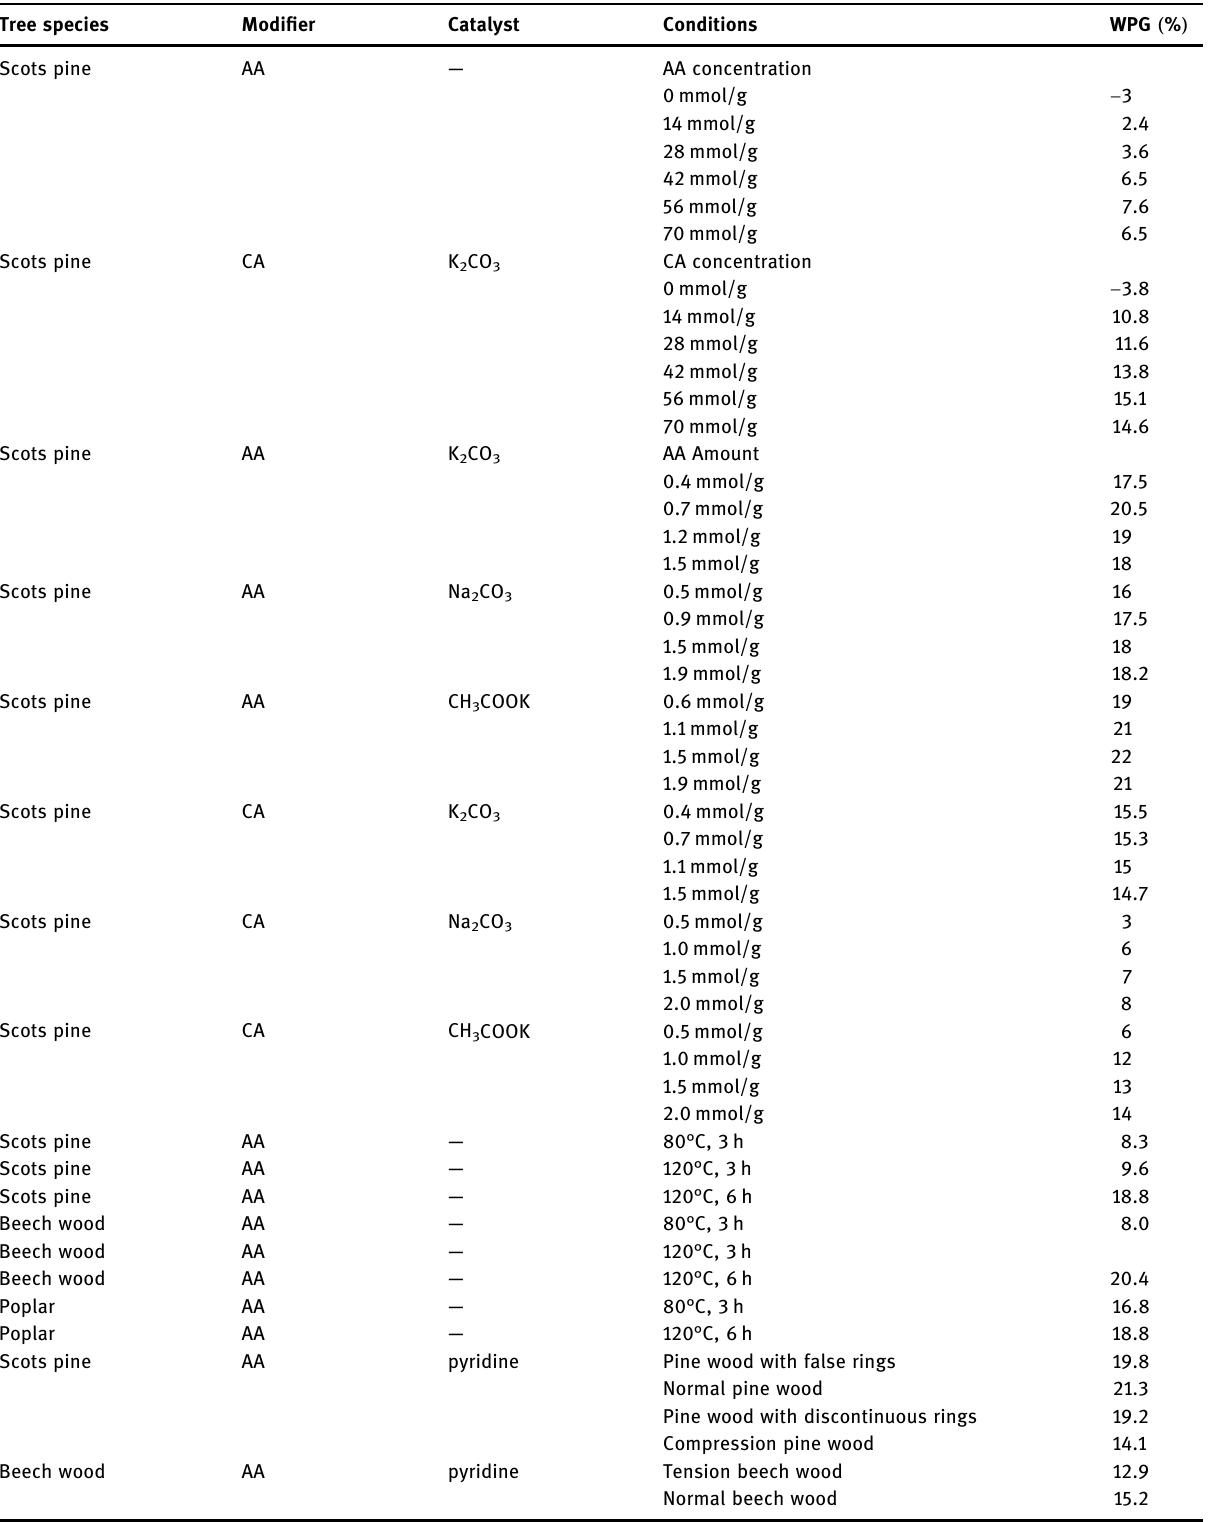
Table 1: The in fl uence of the change of di ff erent factors on WPG [ 2,36,38,39 ]